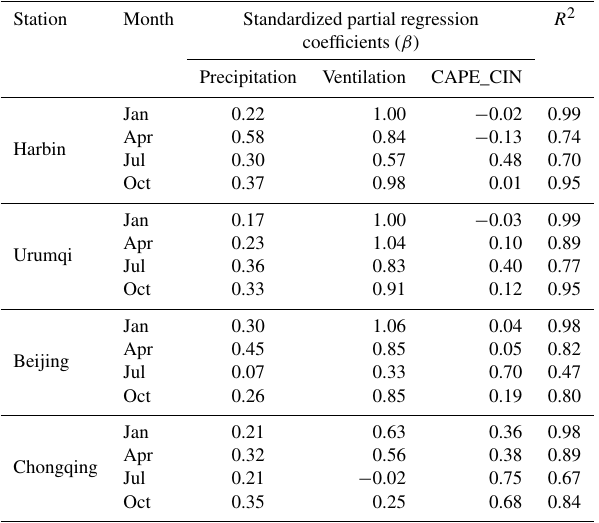
Table 1. Dependence of BSI on its components, i.e., daily precipi- tation, ventilation and CAPE ∗